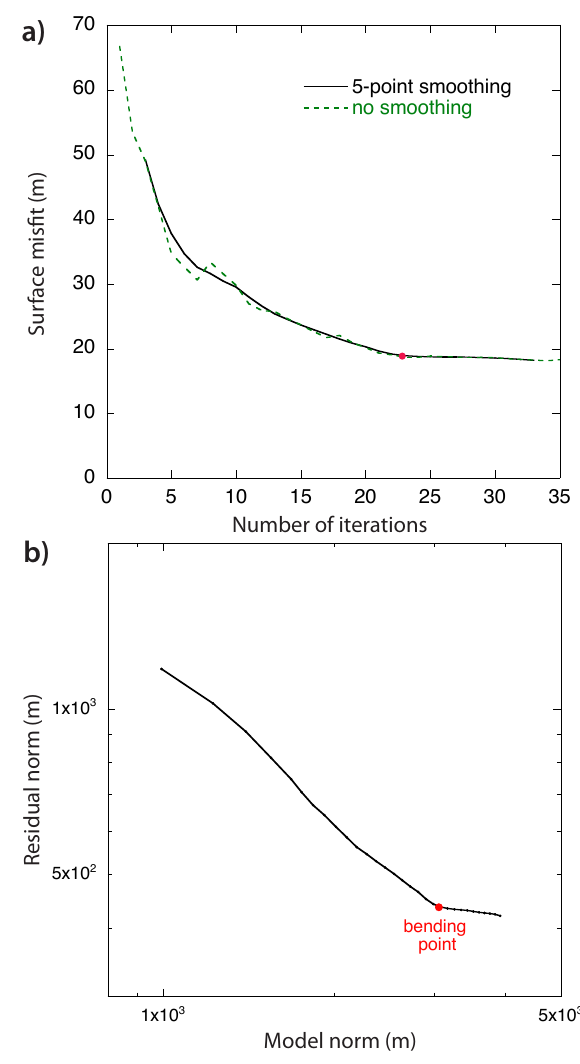
Fig. 10. Plots showing the surface misfit vs. the number of iterations (a) and the residual norm vs. the model norm (b) for the φ = 13 ◦ ex- periment. A bending point in the L-curve, used to define a stopping point for the iterative method, is marked in red. Five-point smooth- ing of the residual norm series facilitates selecting a bending point in (b)